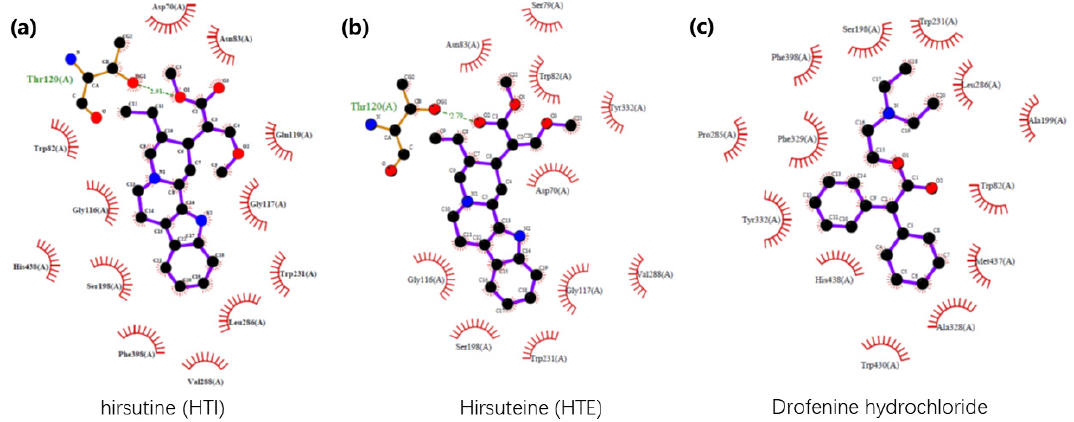
Figure 9. Schematic diagrams demonstrating the butyrylcholinesterase (BChE) binding sites and proximate affinity of hirsutine (HTI), hirsuteine (HTE) and drofenine hydrochloride (a BChE inhibitor). Black dots: carbon atoms; blue dots: nitrogen atoms; red dots: oxygen atoms; green dotted lines: hydrogen bonds; red combs: amino acid residues.